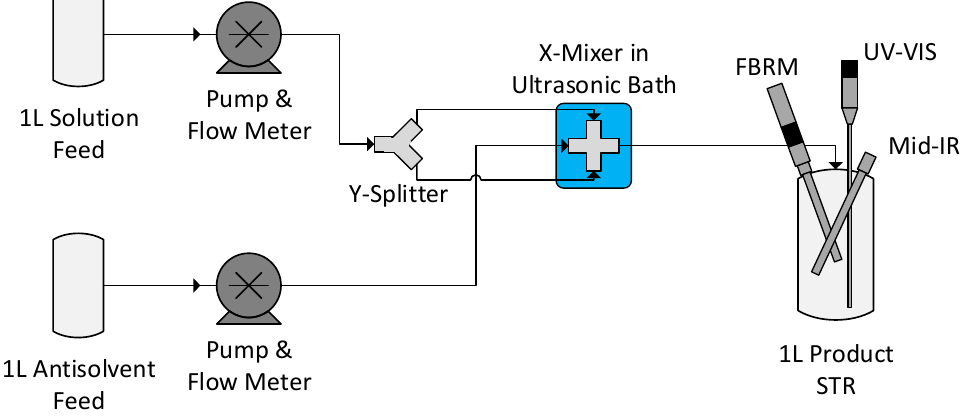
Figure 1. Diagram of the full antisolvent crystallisation setup.